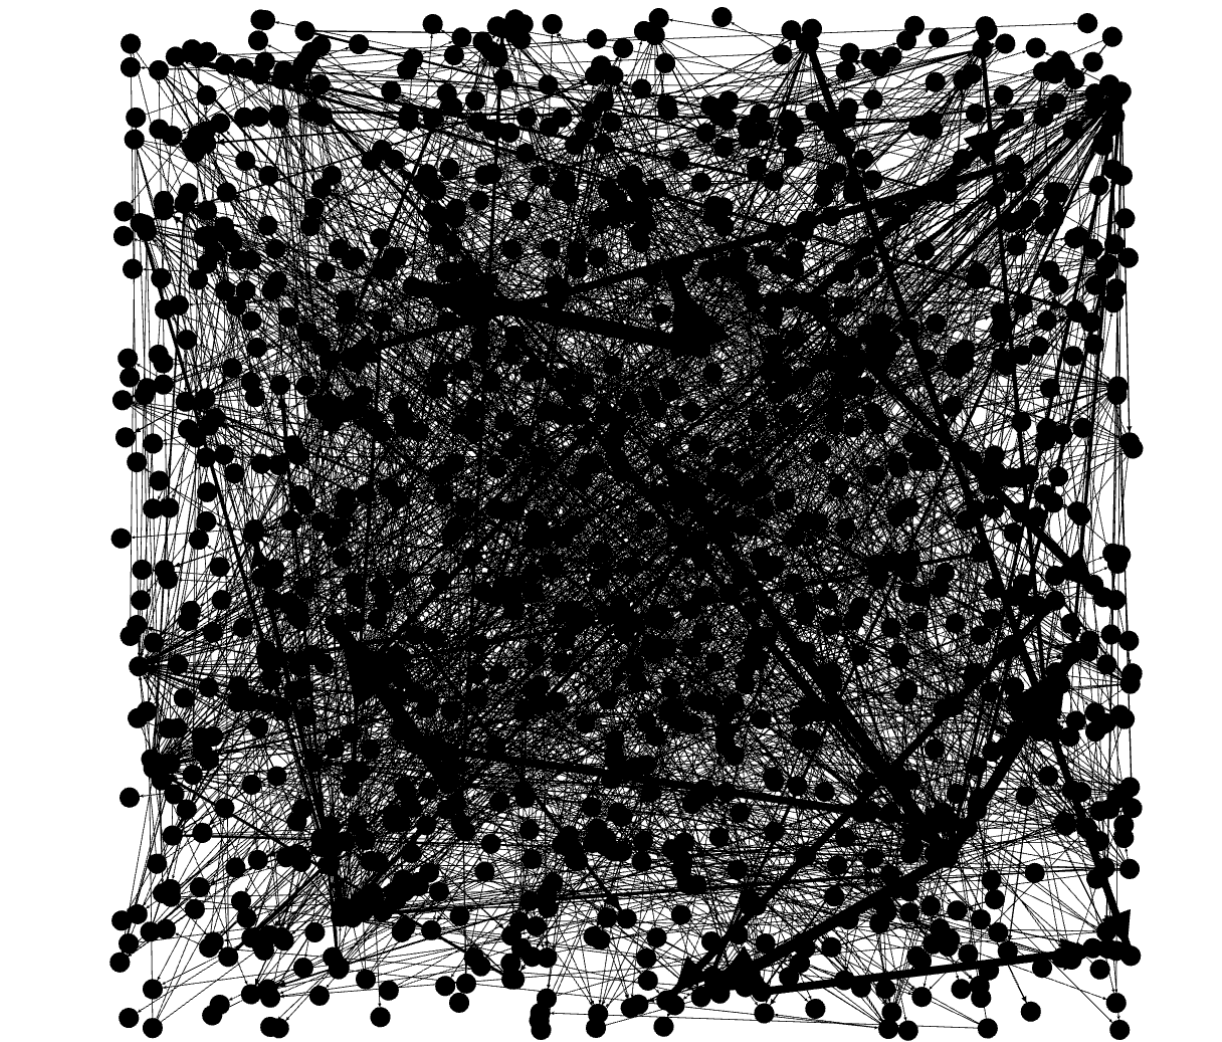
Figure 6. A full social network for all 2053 interactions on the